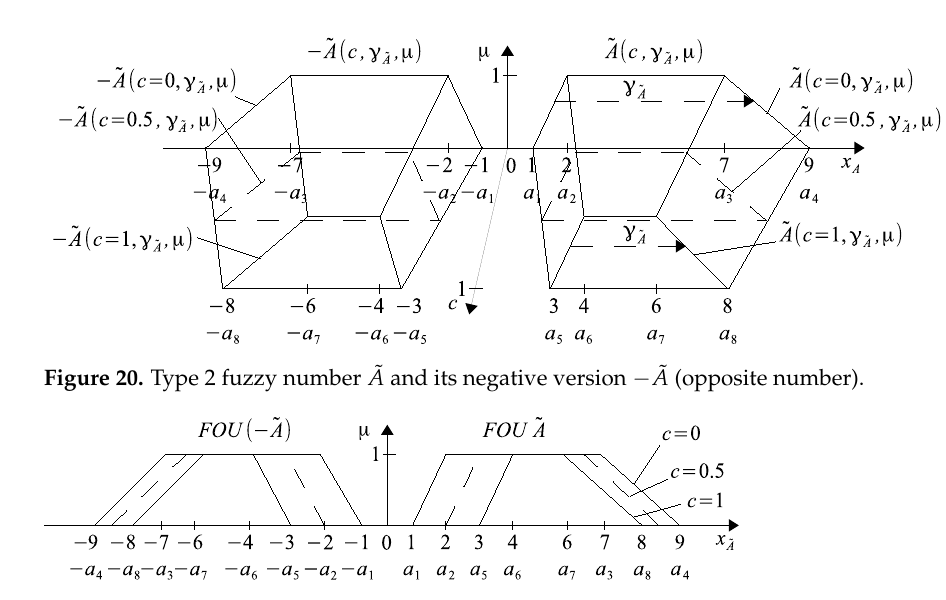
Figure 21. Cuts of T2MF ˜ A and of − ˜ A made for various confidence c -values or FOU ˜ A and FOU ( − ˜ A ) . Inverse type 2 fuzzy number T2FN ˜ A is determined by general Formula (41) and its specific triangular version is given by (42), 0 / ∈ ˜ A .